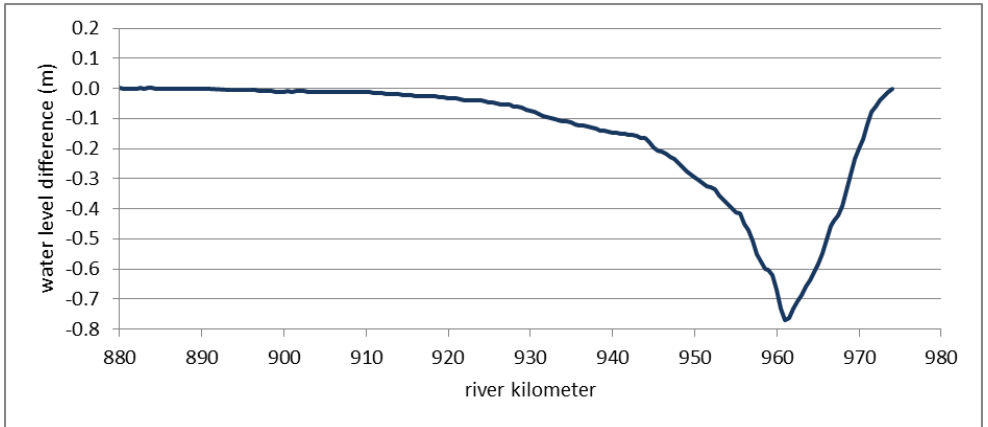
Figure 3. Making room for rivers lowers the flood water level at the location of the intervention and extending upstream of this location. An example for the bypass Veessen-Wapenveld on the IJssel River, implemented 2017, and extending from kmr 961 to 973.